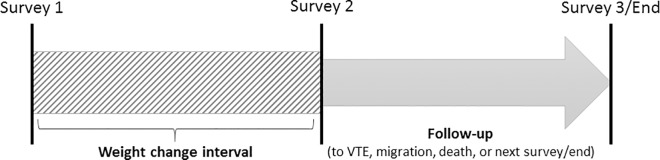
Overview of exposure and follow-up.Exposure was recorded as the change in body weight between two subsequent surveys. Subjects were followed until the date of a third survey or December 31, 2012. Subjects who attended three or more subsequent surveys thus contributed with multiple exposures and follow-up periods.